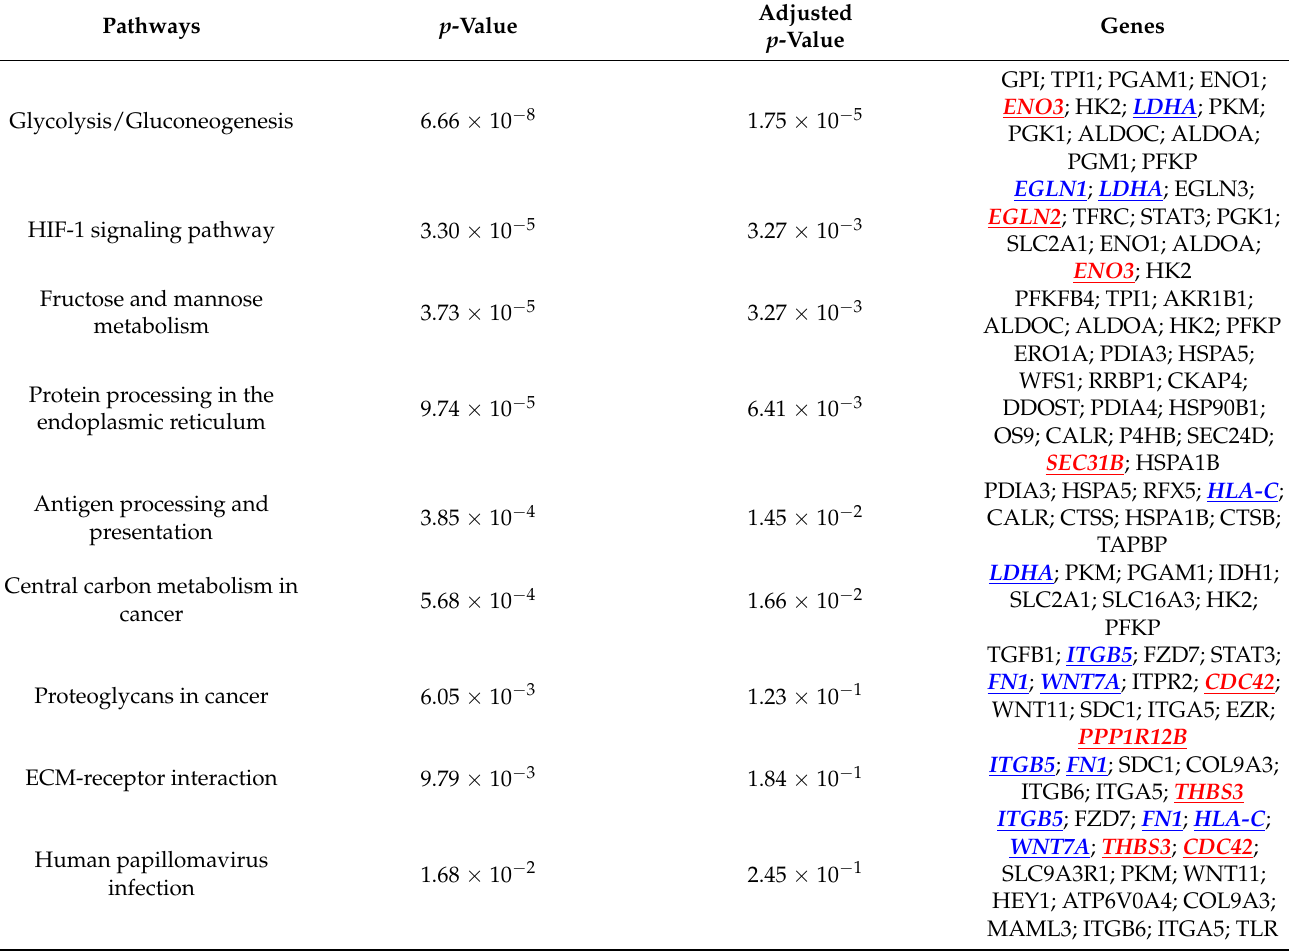
Table 1. Kyoto Encyclopedia of Genes and Genomes (KEGG) canonical pathways enriched in Differentially Expressed Genes (DEGs) with altered expression in the setting of ERAP2N. The underlined red (up-regulated) and blue (down-regulated) genes are the top 50 differentially expressed genes, appearing in multiple enriched pathways and having known functions that could potentially affect the trophoblast cell’s survival or death. The pathways also include genes that are not in the top 50 DEGs (genes in